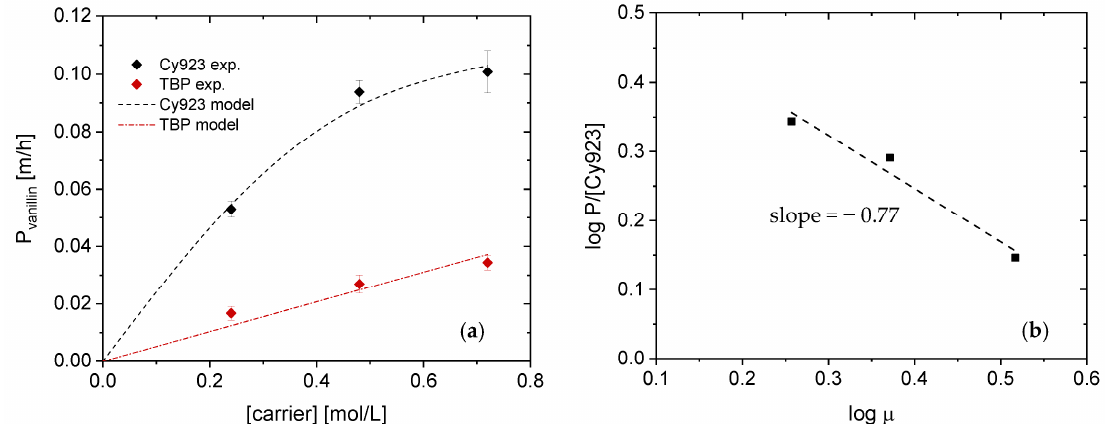
Figure 6. ( a ) Effect of the Cyanex 923 (Cy923) concentration on the vanillin permeability coefficient. ( b ) Effect of the dynamic viscosity on the diffusion coefficient using Cy923 as carrier. FP: 100 mg/L Vanillin in cb pH 4; RP: 0.50 mol/L NaOH.